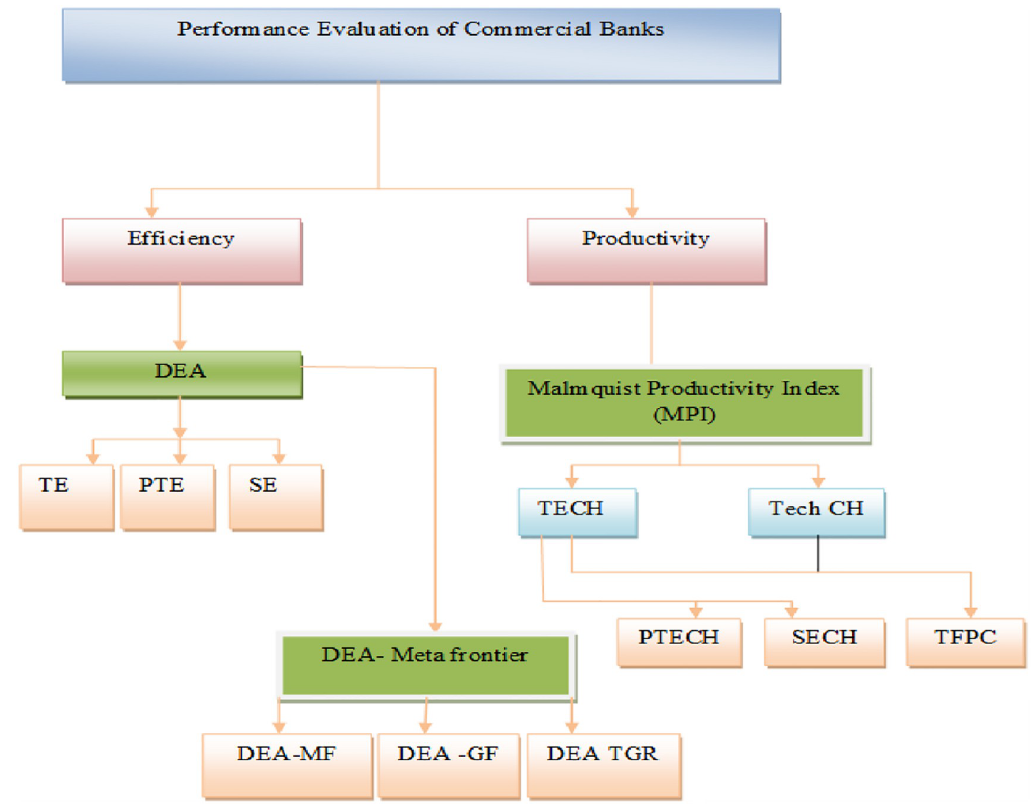
Fig 2. Empirical evaluation outline of South Asian commercial banks’ performance